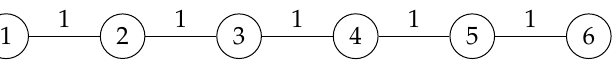
Figure A1. A path graph with six